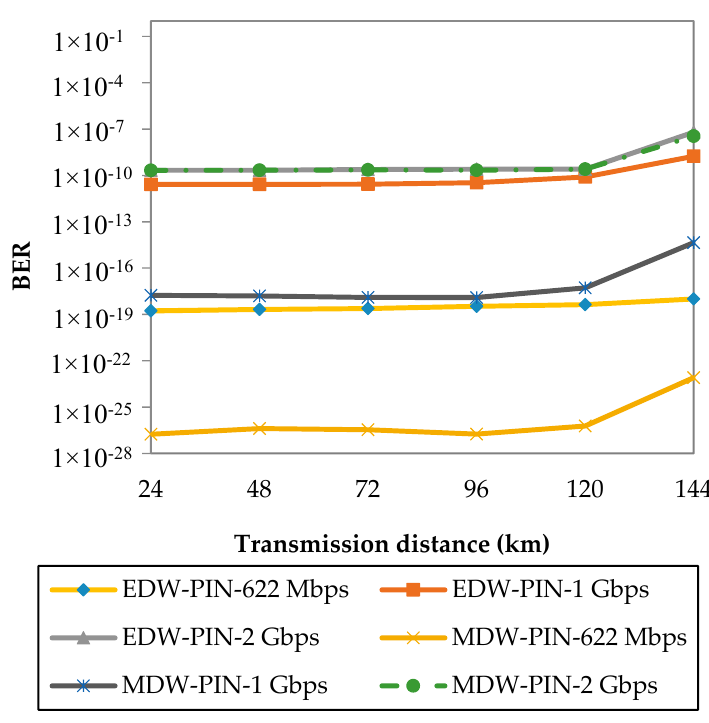
Figure 8. Eye diagram for one user of SAC-OCDMA system using EDW code, sending bit rate of 622 Mbps at 100 km using PIN detector in presence of EDFA.